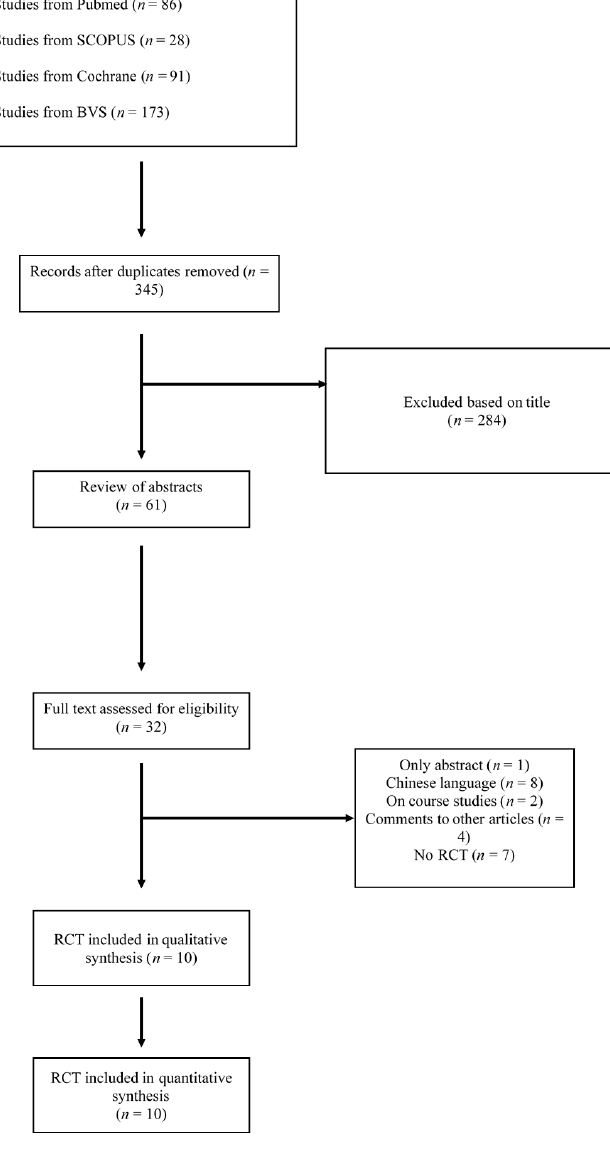
Figure 1. Search flowchart. Figure 1. Search Table 1. Articles selected and included in the meta-analysis.